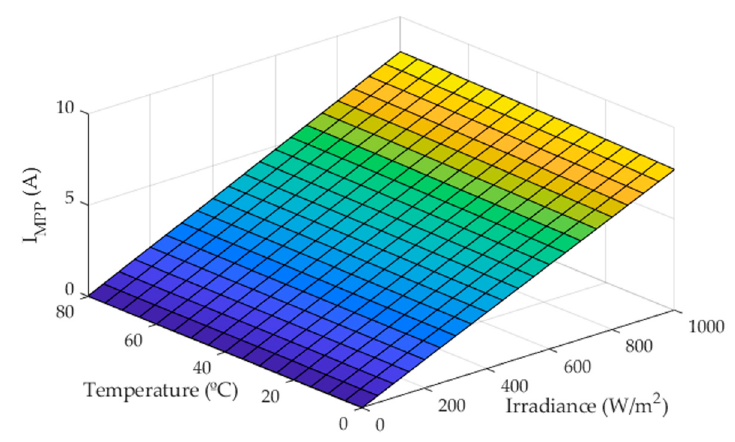
Figure 7. Relationship of MPP current with irradiance and temperature.